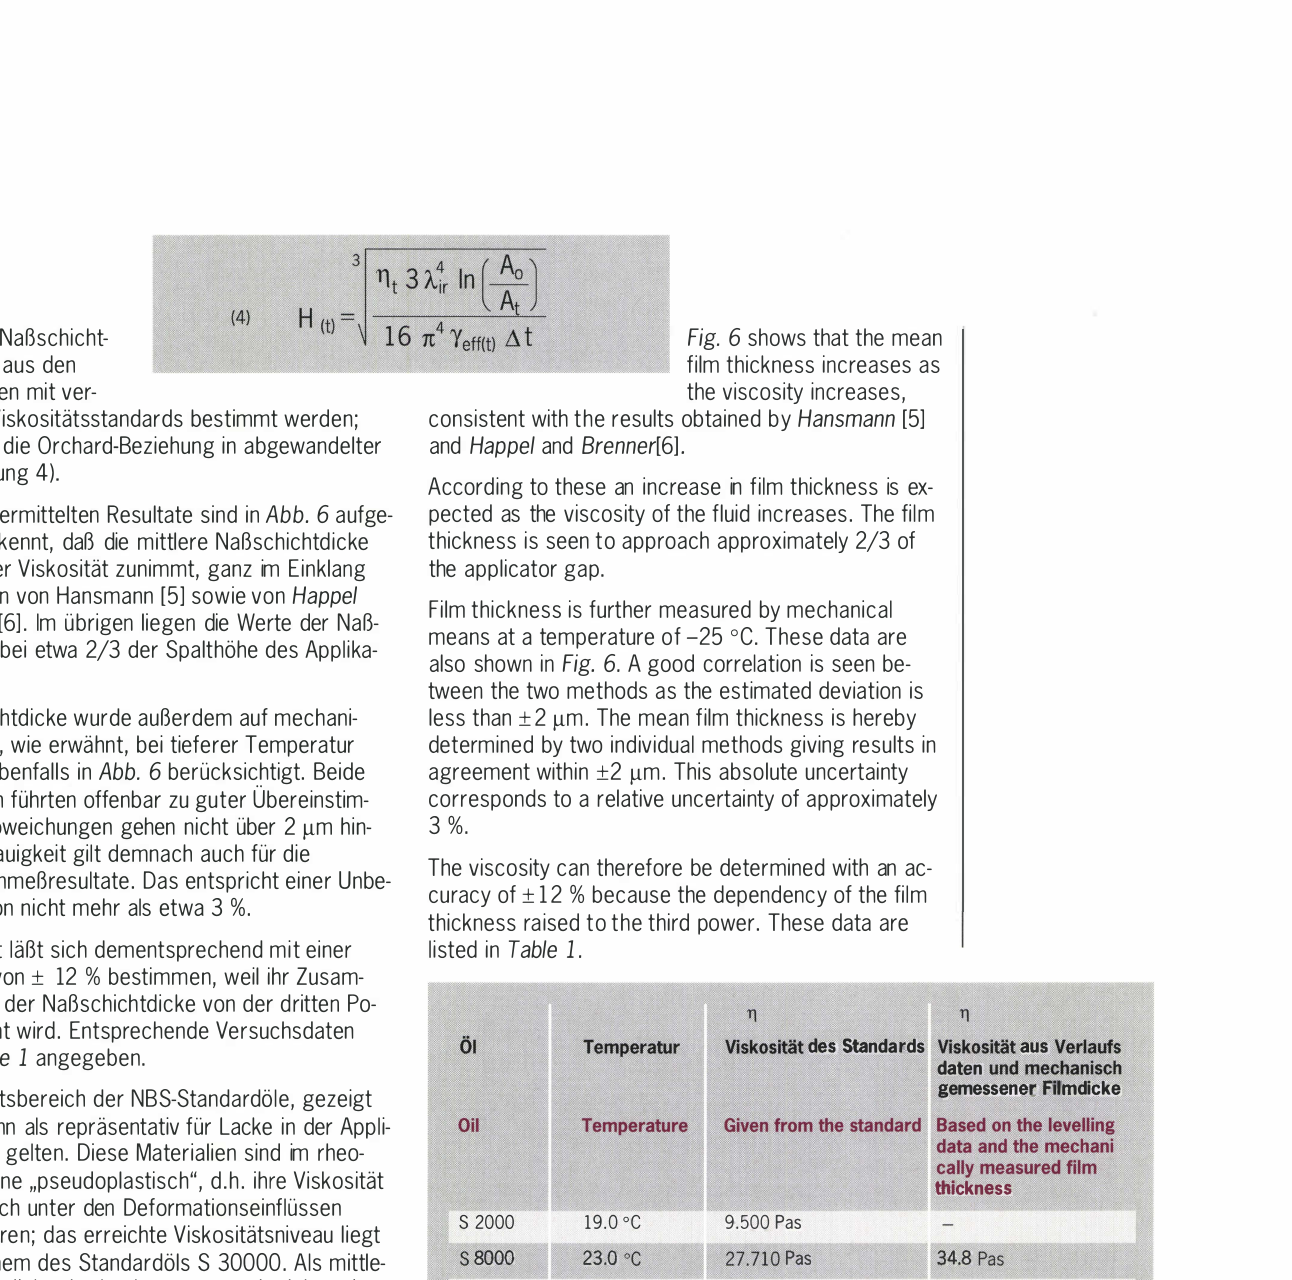
Tabelle 1: Vergleich von realer und aus Verlaufsversuchen ermittel­ ter Viskositiit Table 1: Comparison of the viscosities between the real viscosity and the viscosity based on the levelling